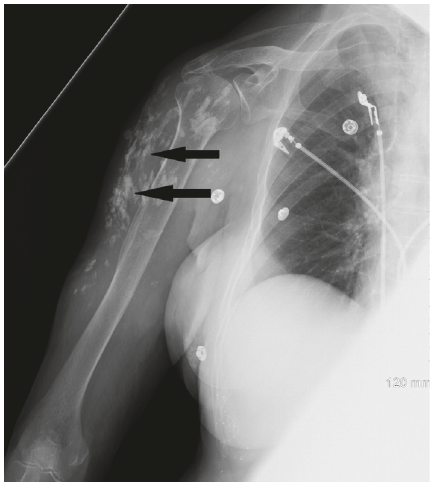
Figure 3: X-ray of the right arm showing soft tissue calcifications.